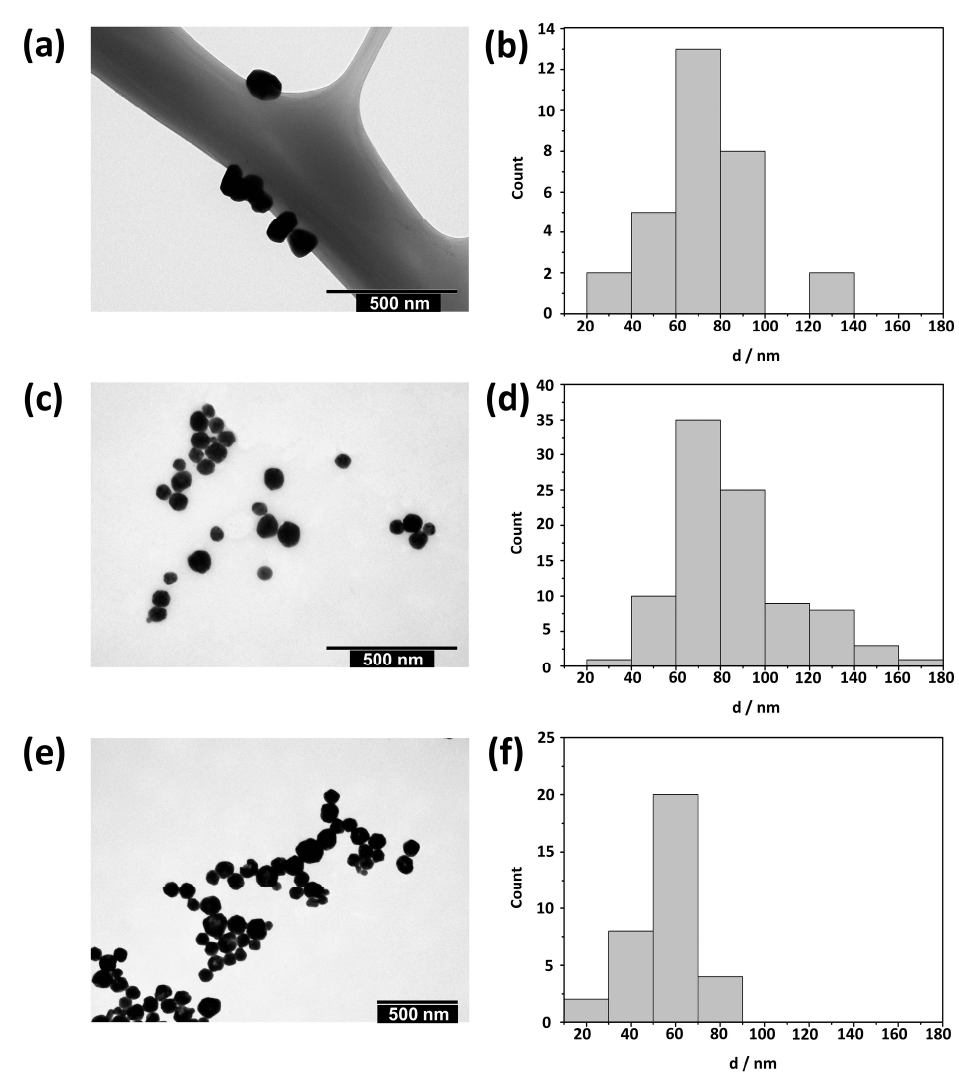
Figure 1. ( a , c , e ) TEM micrographs and ( b , d , f ) corresponding size distributions of silver nanopar- ticles stabilized with ( a , b ) citrate, ( c , d ) poly(vinylpyrrolidone), and ( e , f ) sodium bis(2-ethylhexyl) sul- fosuccinate.